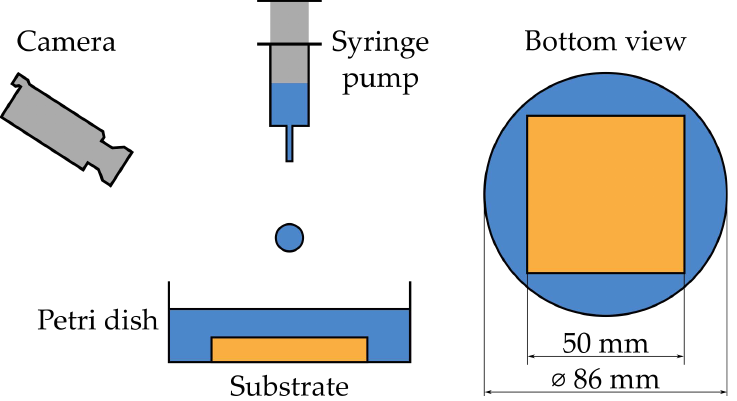
Figure 1. Schematic of the film rupture experiment.